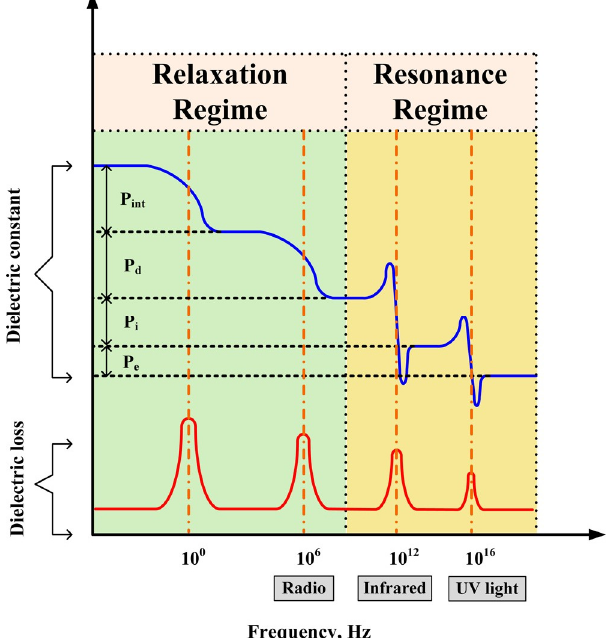
Figure 3. Polarization types at different frequencies. P e , P i , P d , and P int refer to e-polarization, ion-polarization, dipole-polarization, and interfacial polarization, respectively. Adapted with permis- sion [6]. Copyright 2016, American Chemical